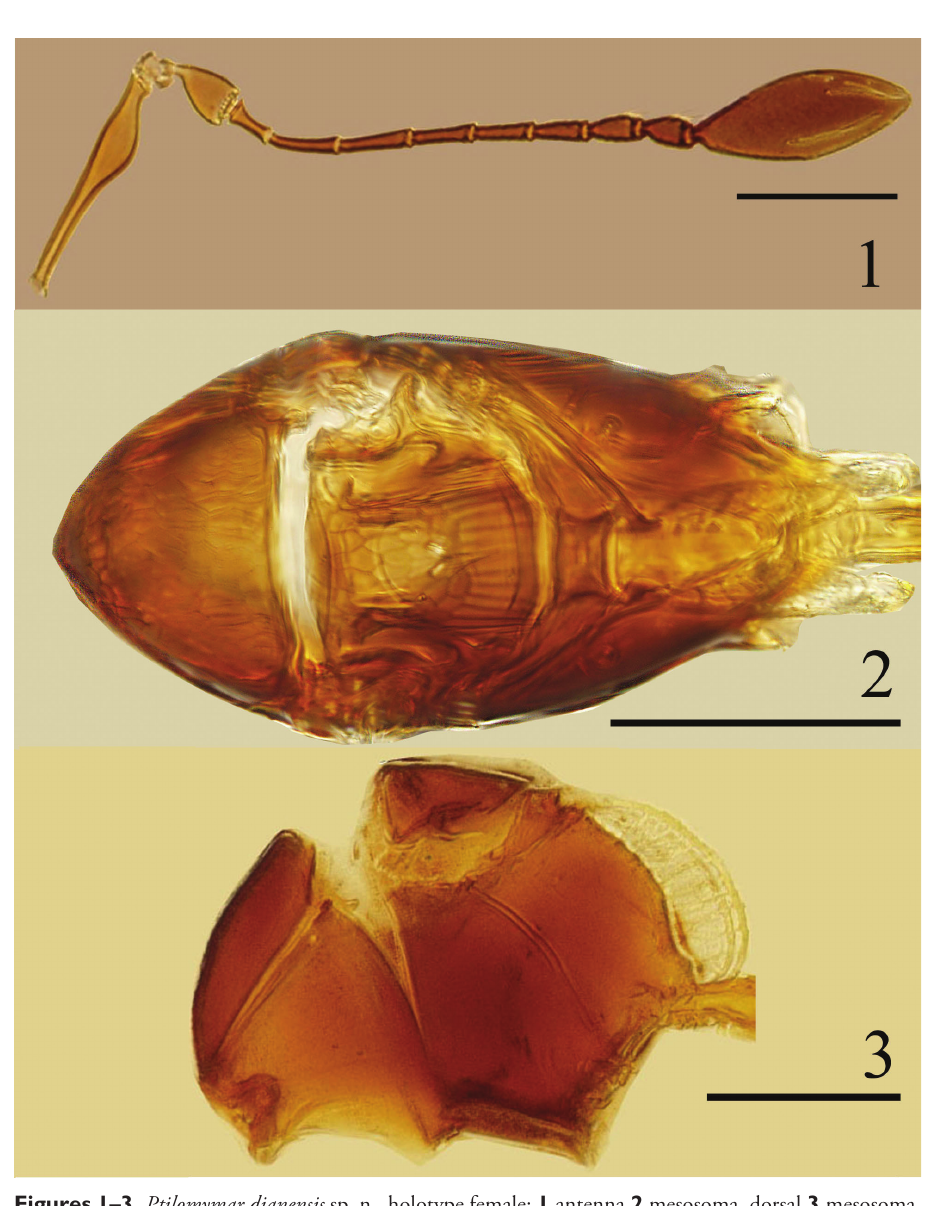
Figures 1–3. Ptilomymar dianensis sp. n., holotype female: 1 antenna 2 mesosoma, dorsal 3 mesosoma, lateral. Scale bars=100